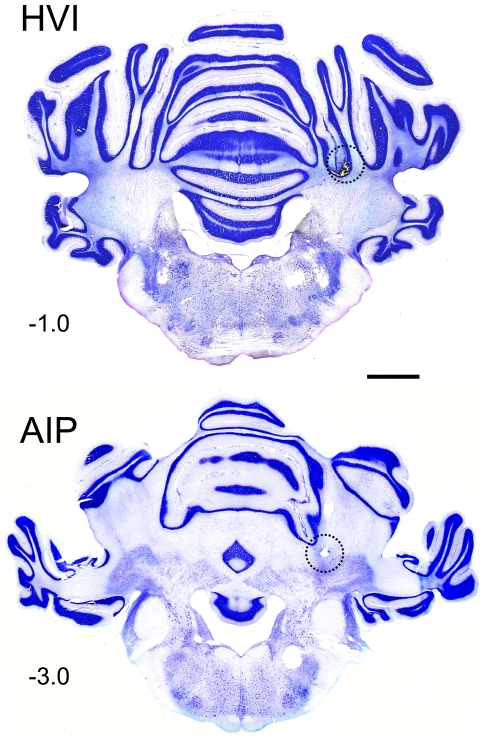
Histological identification of cannula tip and spread of infusion.Photomicrographs of 50 µm transverse cerebellar sections from a experimental subject from the Cortex+Nucleus group. Sections are stained with cresyl violet, showing location of cortical (HVI) and nuclear (AIP) cannula tips (arrowhead). Positions relative to skull λ are indicated (mm). The approximate extent of diffusion of pontamine sky blue dye (2 µl for cortex, 1 µl for nuclei) was plotted on adjacent neutral red-stained sections, and superimposed on the current sections (dotted lines). Calibration bar represents 2 mm.